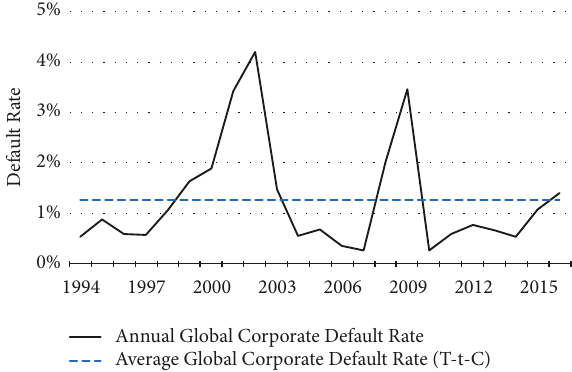
Figure 1: Global Corporate Default Rates (1994–2016).